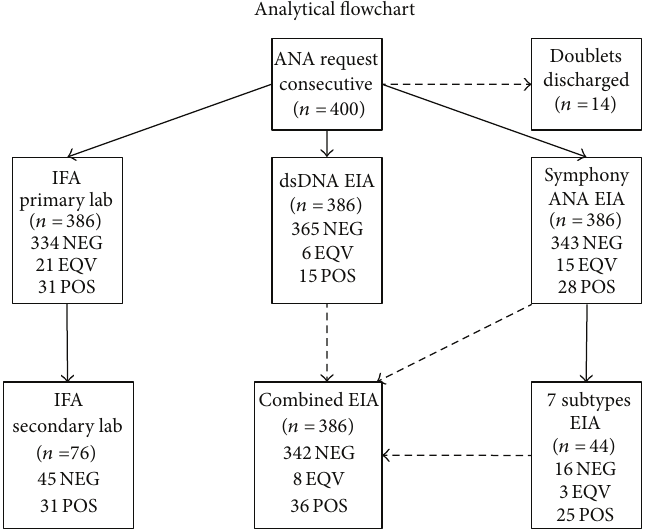
Figure 1: Analytical flowchart. EIA with a combination of dsDNA, ANA Symphony, and the 7 subantigens (SmD, U1RNP, SSA/Ro, SSB/La, Scl-70, CENP-B, and Jo-1) is referred to as “Combined EIA.” IFA tests were performed at a primary laboratory (Gentofte Hospital) and a secondary laboratory (Statens Serum Institut). NEG: negative, EQV: equivocal, POS: positive, and ND: not